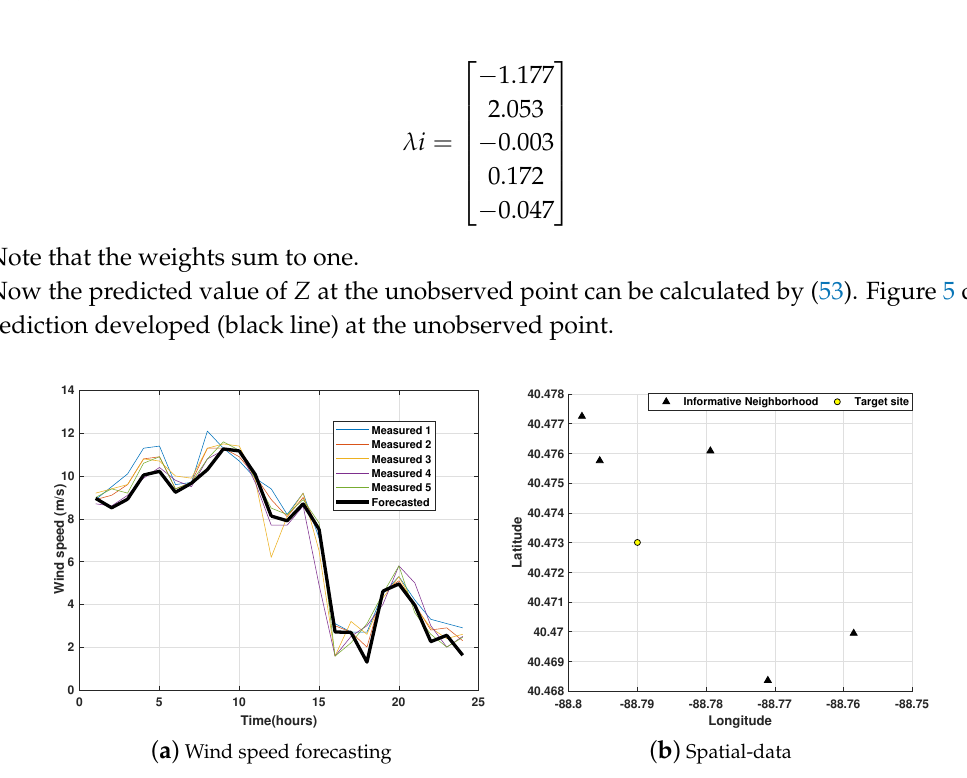
Figure 5. Spatio-temporal wind speed data. ( a ) depicts the wind speed measured data, and the wind speed forecasted. ( b ) depicts the coordinates of the measured points and the target